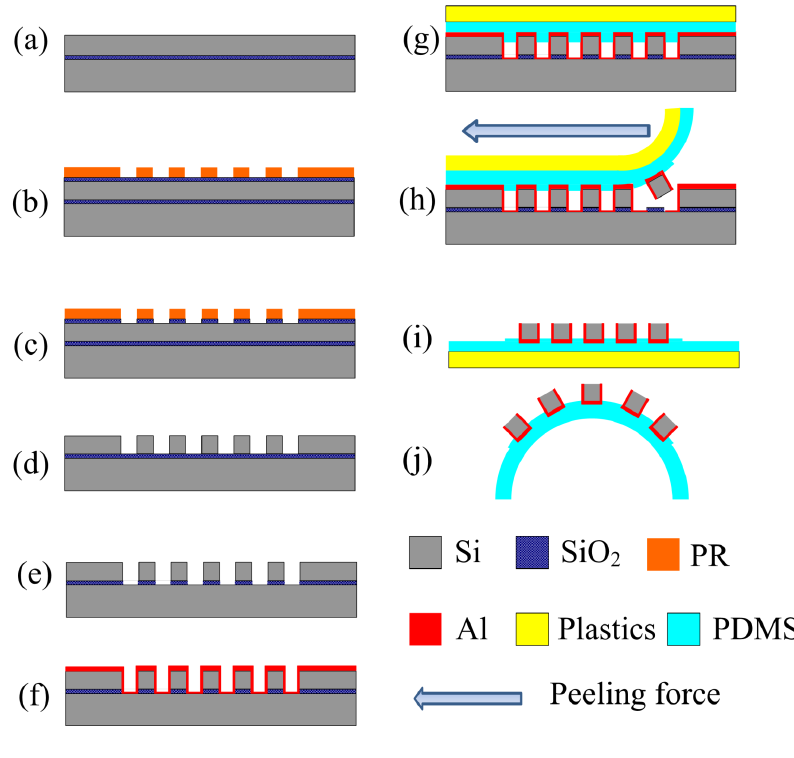
Figure 2. Schematic illustrating the detailed fabrication process of the peeling micro-transfer-printing method applied to realize our device. ( a ) A large-area array of micro-mirrors fabricated on an SOI wafer by the following steps: ( b ) Contact-mode standard lithography; ( c ) Etching of oxide hard mask by RIE; ( d ) DRIE process; ( e ) Si sidewall smoothening by a 45% KOH wet-etching process. Plus, a selective undercut etching of the BOX layer by BOE solution; ( f ) Al sputtered onto the Si pillars to create an array of micro-mirrors; ( g ) A transparent, flexible PDMS membrane pressed against the structured SOI wafer to achieve conformal contact; ( h ) A peeling stress in the lateral direction lifting the micro-mirror array onto the PDMS membrane; ( i ) Micro-mirror array successfully transferred onto the PDMS membrane; ( j ) The fabrication concluded with the production of an array of micro-mirrors on a cylindrical PDMS membrane. The dimensions in this figure are not to